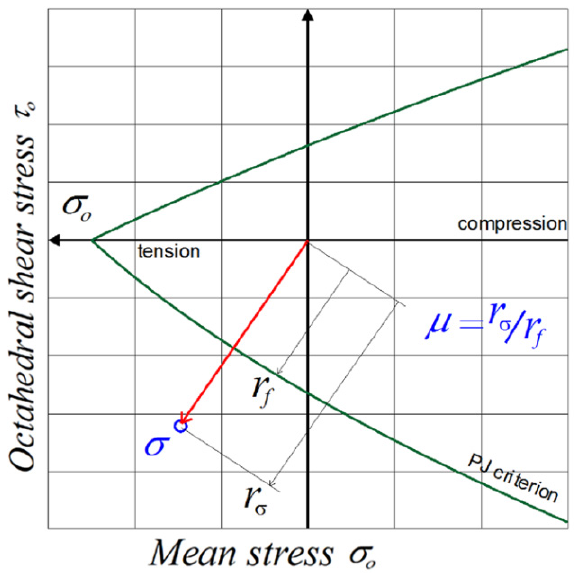
Figure 16: Definition of the material effort ratio